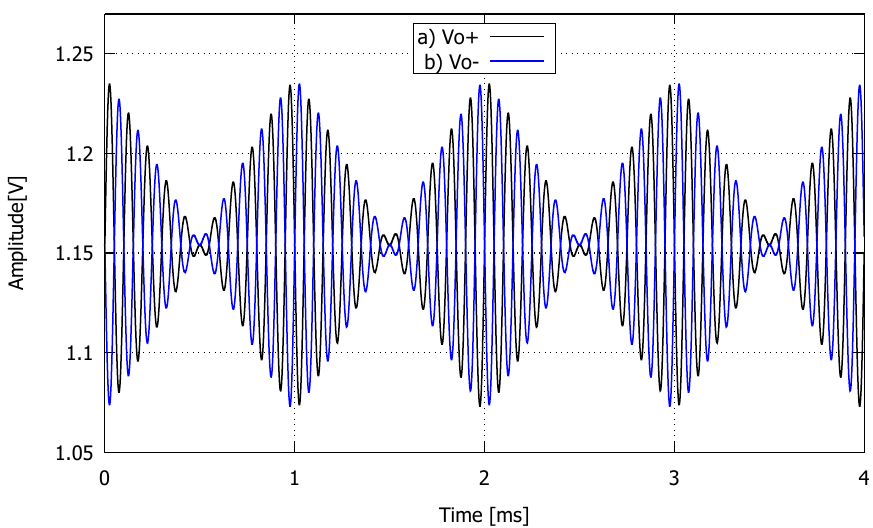
Figure 8. Multiplier transient